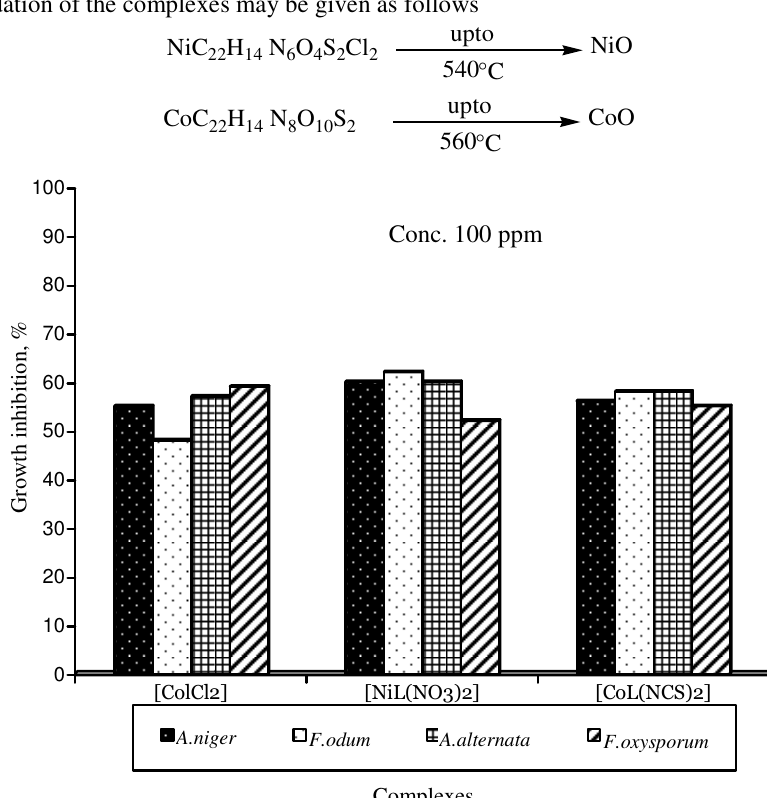
Figure 5 . Antifungal screening data of the